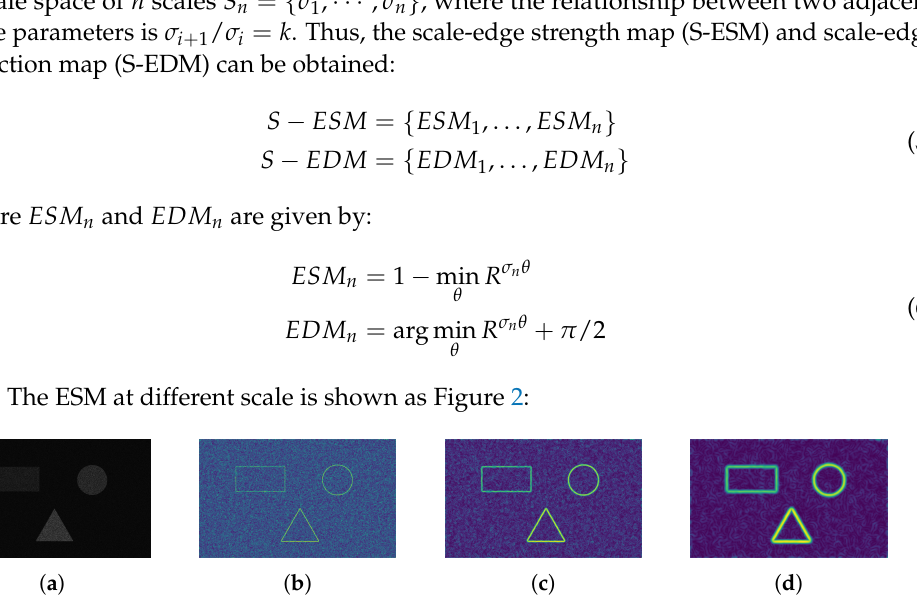
Figure 2. The ESM of different scale: ( a ) Simulated SAR image. ( b ) n = 1. ( c ) n = 3. ( d ) n =